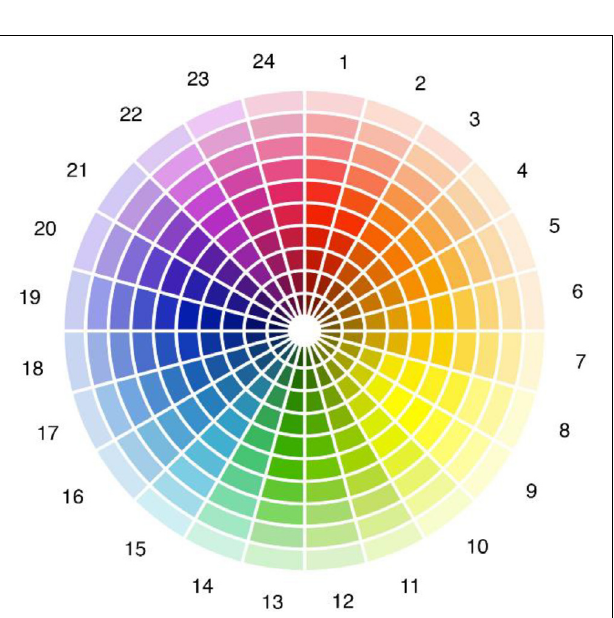
FIGURE 4 | Color wheel for the assessment of chromatic preference. The wheel included 24 sectors varying in hue. Each sector included 10 levels along the radial dimension varying in